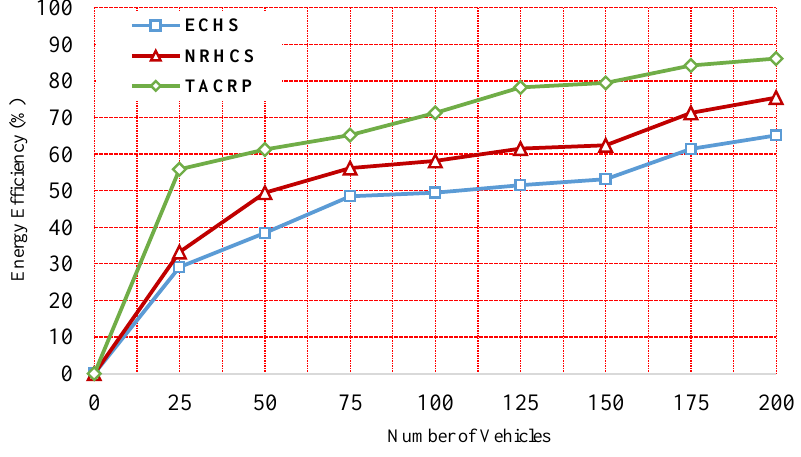
Figure 4. Energy Efficiency Calculation.